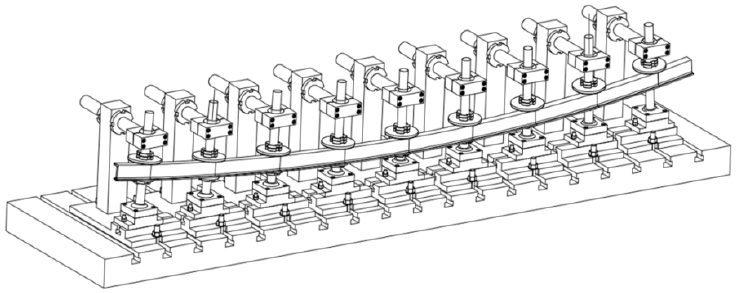
Figure 2. The FSB (Flexible 3D stretch bending) machine.